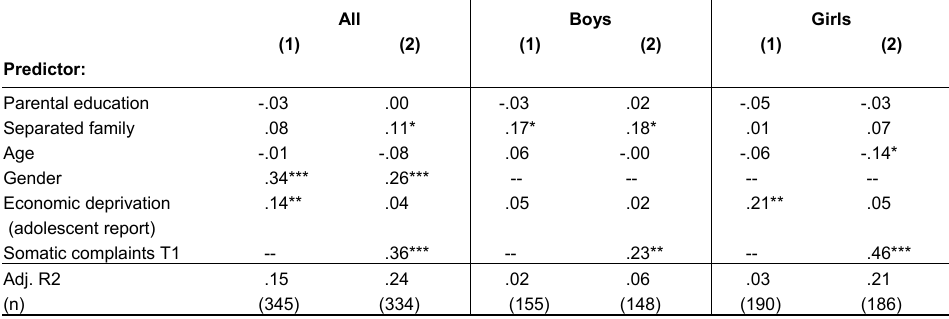
Table 3 : Effects of economic deprivation on offspring somatic complaints six years later All Boys